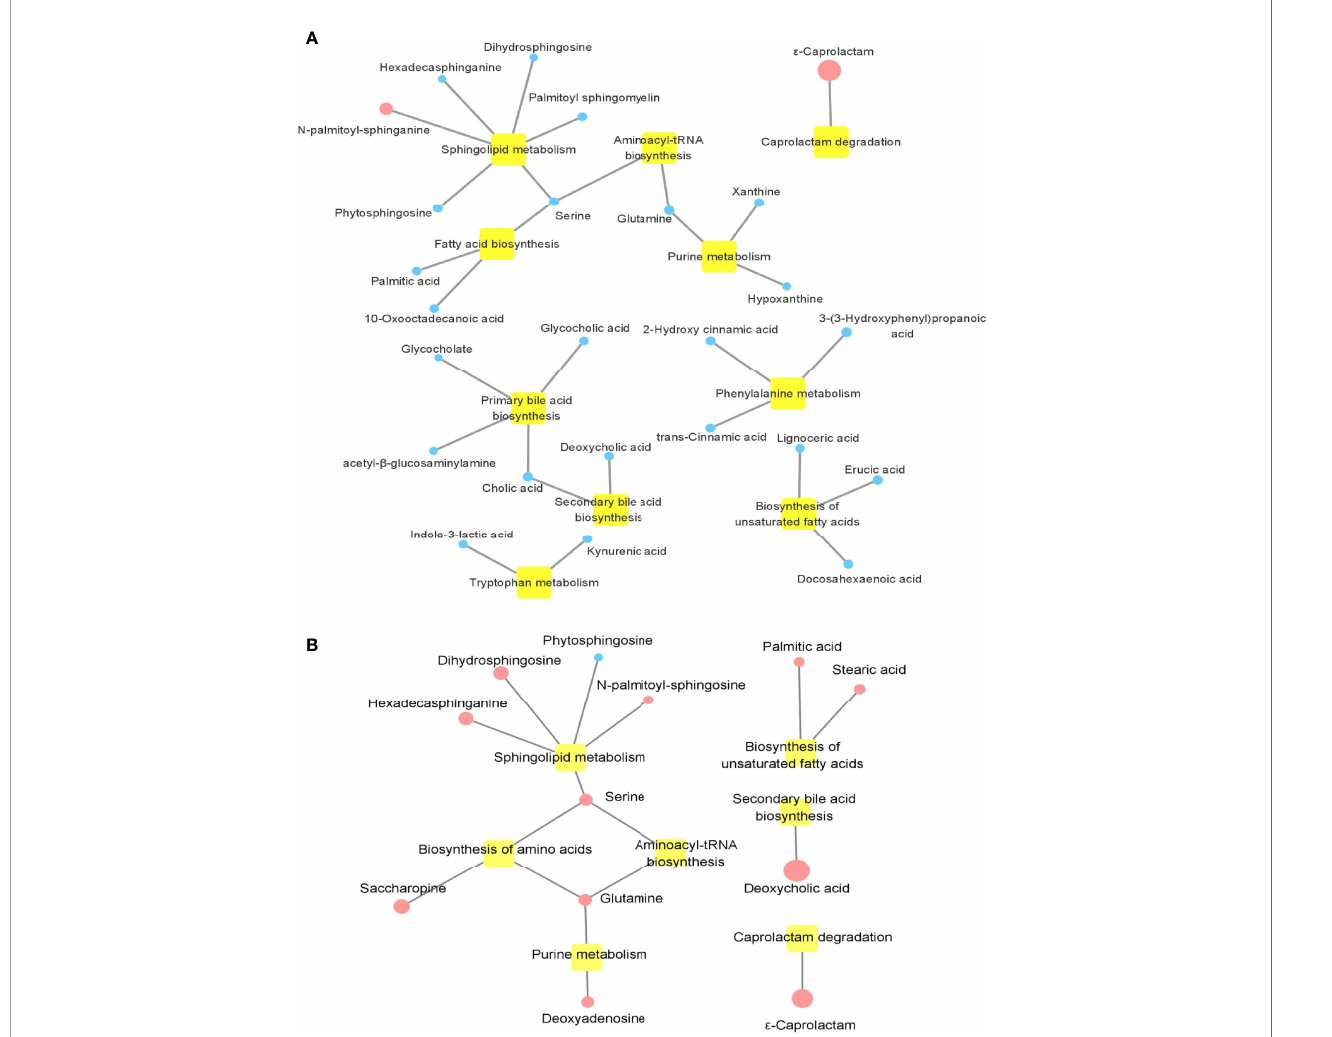
FIGURE 6 | Enrichmentmapofmetabolicpathwaysinvolvedindifferentialmetabolites. (A) MetabolicpathwaysinvolvedindifferentialmetabolitesbetweenPsAandHC. (B) Metabolic pathwaysinvolvedindifferentialmetabolitesbetweenPsAandRA.Yellownodesrepresentmetabolicpathwaysinvolved.Circularnoderepresentsthechangeinmetabolite,whereblue indicatesadecreaseinPsA,andredindicatesanincreaseinPsA;thesizeofthecircleindicatesthefoldchangeofmetabolitesinPsAcomparedwithHCorRA.